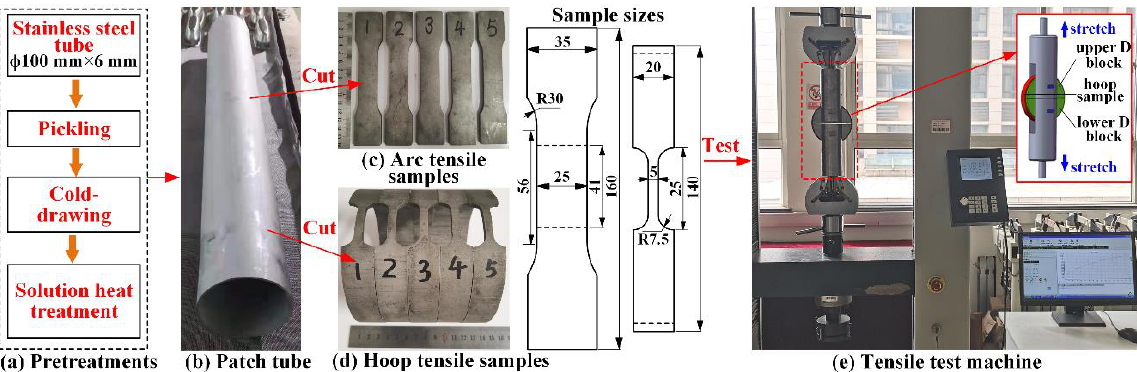
Figure 6. Preparation and mechanical properties analysis of AISI 321 patch tube.